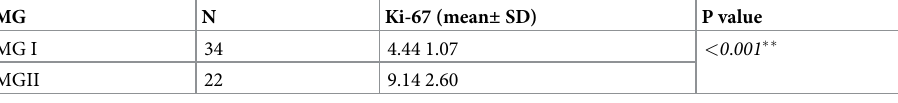
Table 2. Role of Ki67 marker in different grades of meningioma (Student’s t test). MG